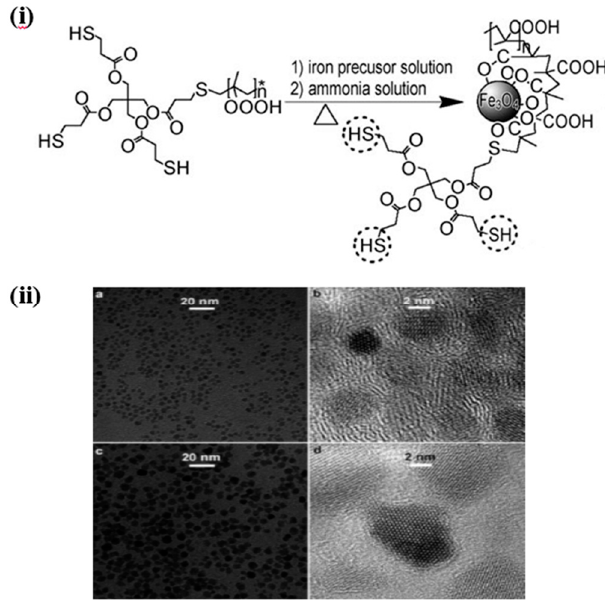
Figure 5. Scheme illustrating the ( i ) Synthesis of MIONs; ( ii ) TEM images ( a,b ) 4.5-nm and ( c,d ) 8.5-nm PMAA–PTTM protected Fe 3 O 4 nanocrystals. The molar ratio between carboxylic acid groups and FeCl 3 ·6H 2 O in both cases is 3:4 [57].